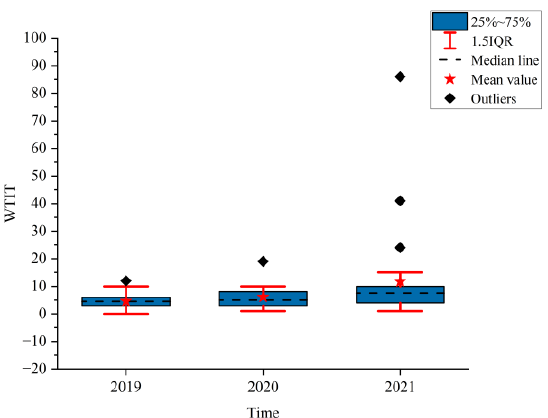
Figure 4. WTCT. Figure 5. Fixed base growth rate of WADT.